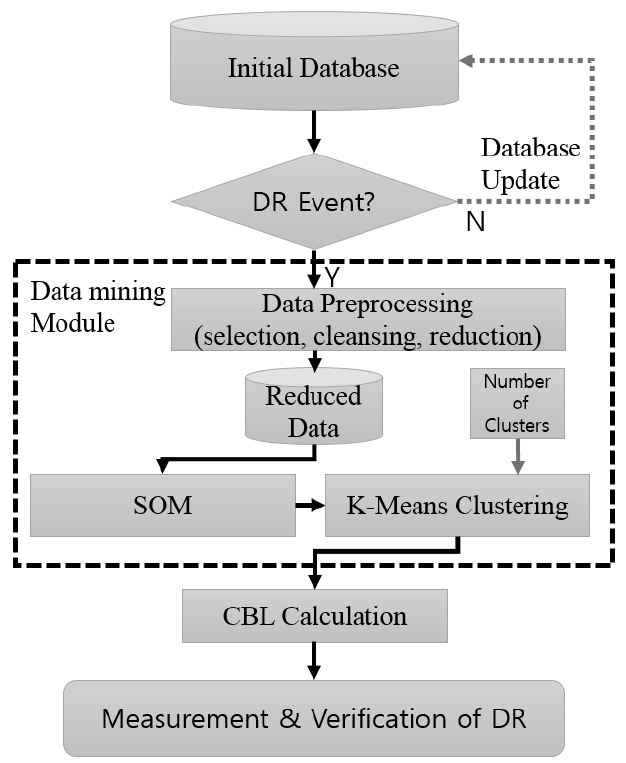
Figure 1. Framework for the baseline load computation. DR: demand response; SOM: self organizing map; CBL: customer baseline